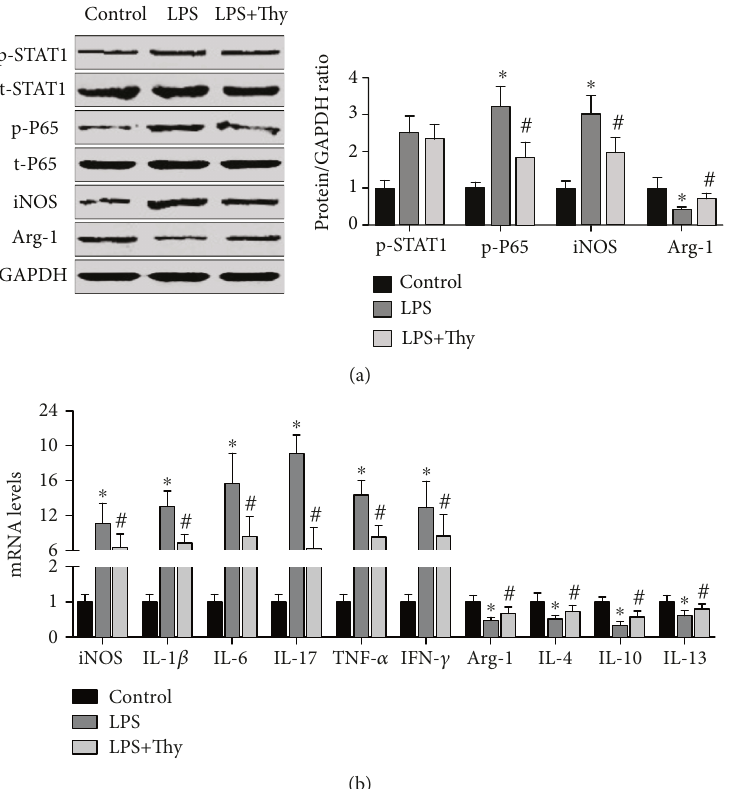
Figure 1: E ff ects of levothyroxine on LPS-induced Mø di ff erentiation. (a) STAT1 phosphorylation, p65 phosphorylation, iNOS, and Arg-1 levels were measured by western blot. (b) The iNOS, IL-1 β , IL-6, IL-17, TNF- α , IFN- γ , Arg-1, IL-4, IL-10, and IL-13 mRNA levels in each group were detected by RT-qPCR. N = 5 in each group. ∗ P < 0 05 vs. the control group. # P < 0 05 vs. the LPS group.